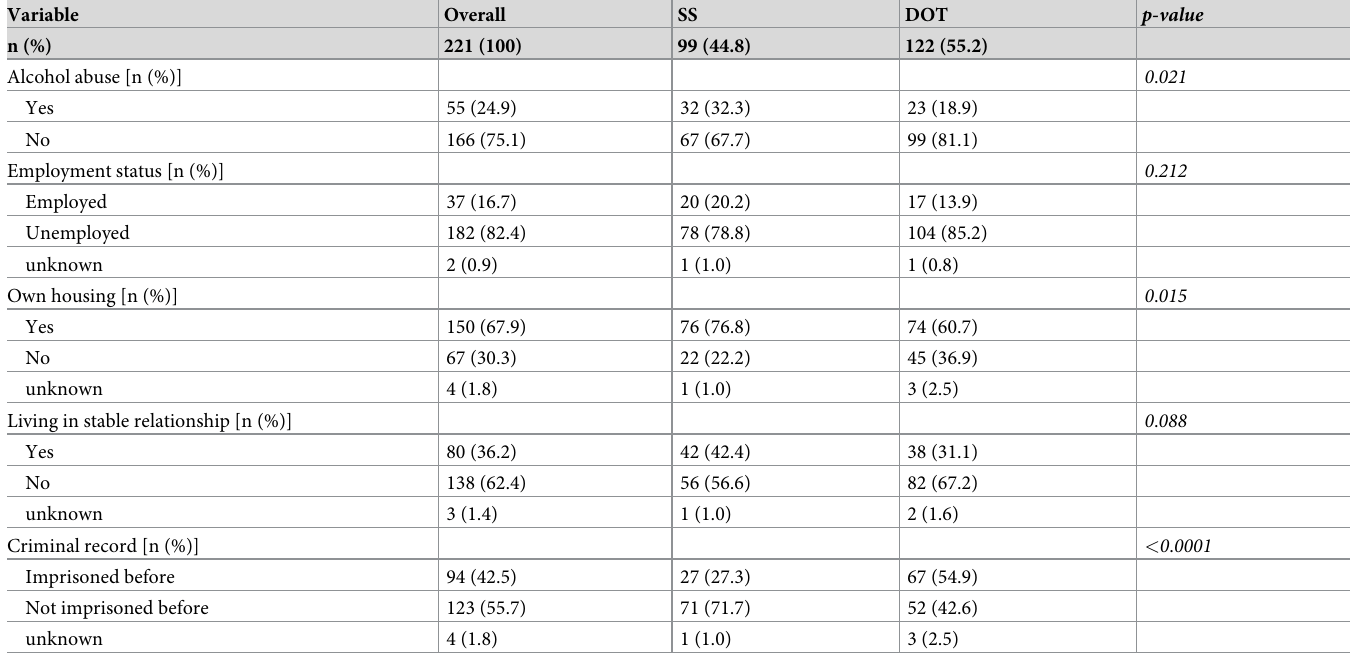
Table 2. Socioeconomic characteristics of study population at